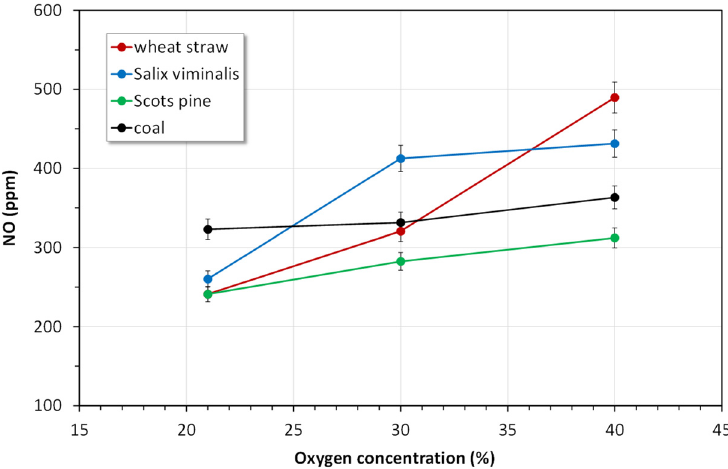
Figure 13. Influence of oxygen concentration on the total emission of NO during oxy-combustion. Vertical bars represent standard deviation.